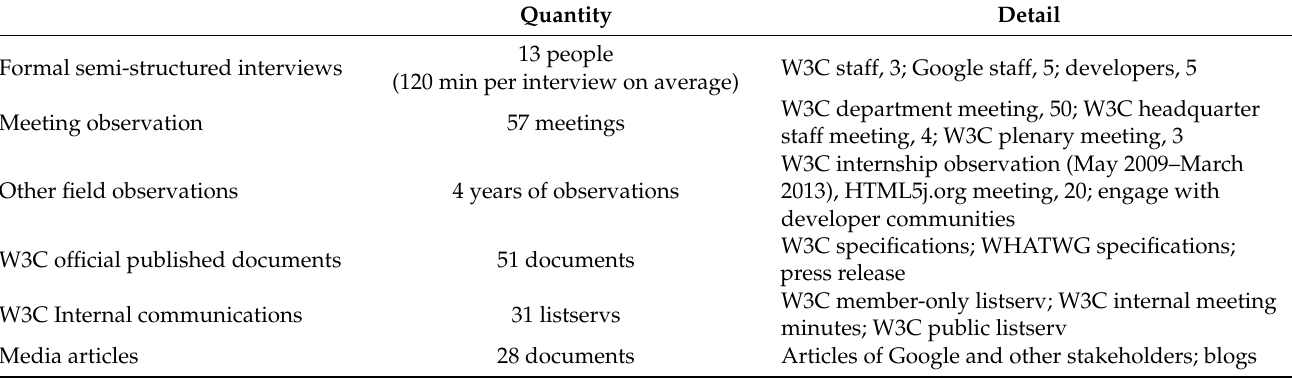
Table 1. Main Data